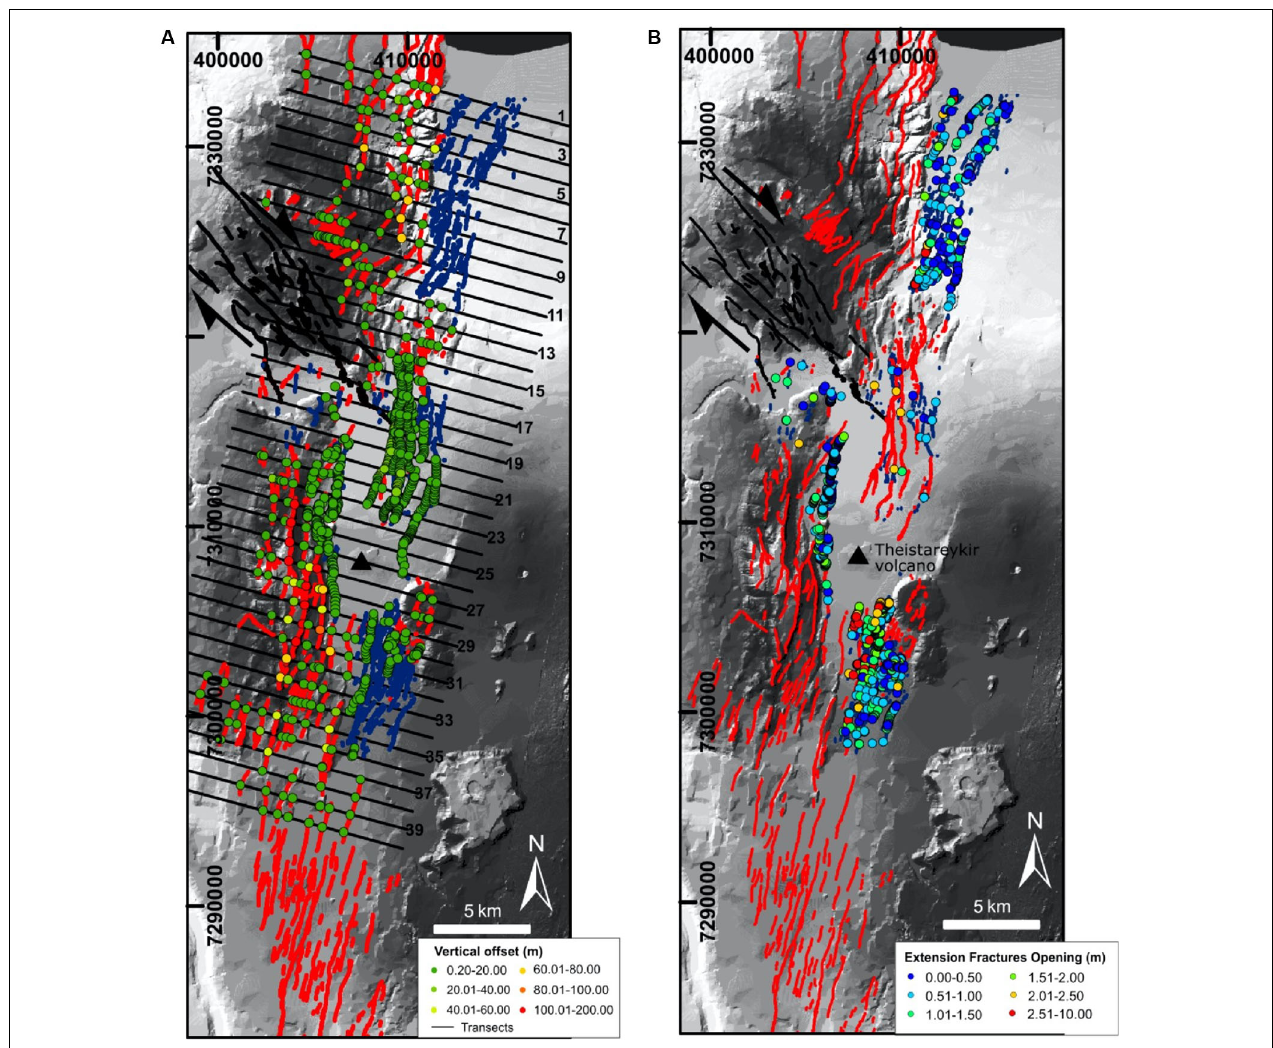
FIGURE 8 | (A) Distribution of measurements of vertical offset values at normal faults and (B) net opening amount values at extension fractures. Black lines show transects along which extension was cumulated. Spatial reference: datum WGS 84/UTM zone